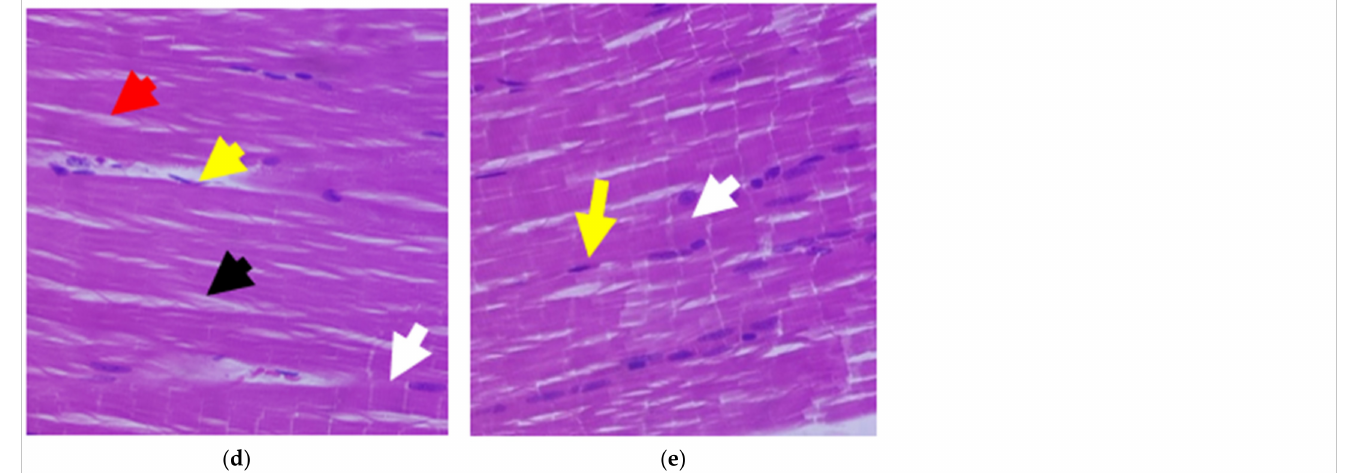
Figure 9. Effect of C. papaya on the histopathology of skeletal muscle tissue: ( a ) Control rats; ( b ) type- 2 diabetic rats showed discontinuity in the muscle fiber’s (black arrow) wide space between the myofibrils (red arrow) when compared to the control; ( c ) type-2 diabetic rats treated with C. papaya (600 mg/kg b.wt) showed a restored architecture of skeletal muscle when compared to type-2 diabetic rats; ( d ) type-2 diabetic rats treated with metformin (50 mg/kg, b.wt) also restored the skeletal muscle structure to a level close to the normal control rats; and ( e ) control rats treated with C. papaya (600 mg/kg b.wt). Acidophilic myofibers arranged in bundles (white arrow) with a peripherally placed and flattened nucleus (yellow).